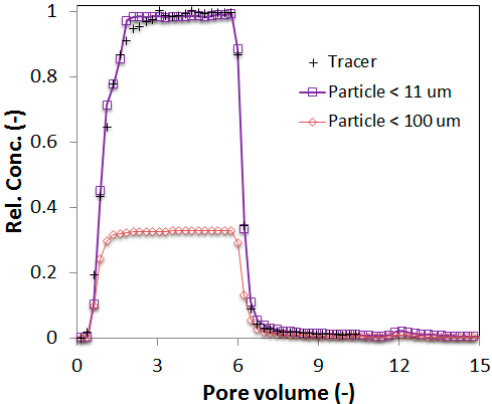
Figure 5. Representative FBP breakthrough curves from column experiments using extinguishing water collected at site 2 after filtration using two different particle sizes.